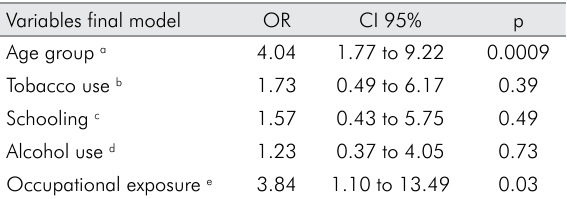
b Exposure to acid mists = 1; non-exposure = 0. c Number of years of smoking. d Fagerström questionnaire score. e AUDIT questionnaire